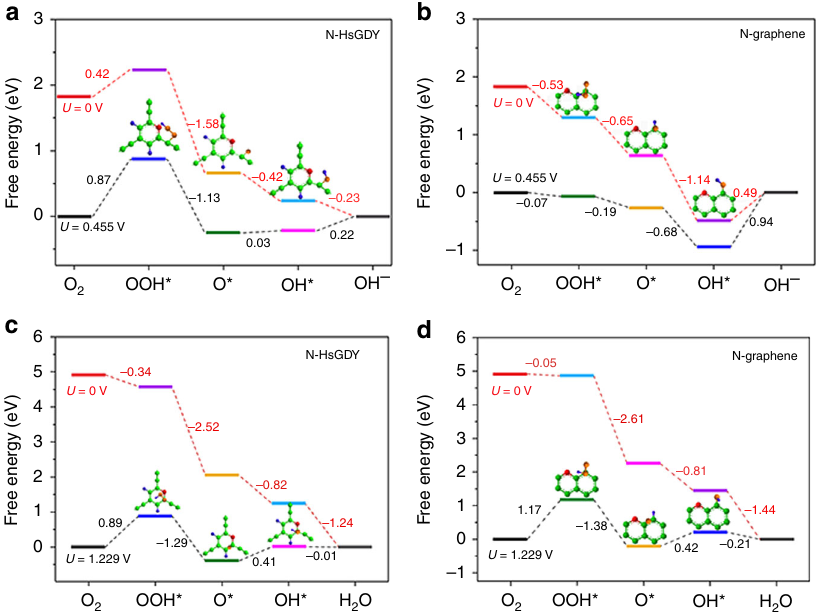
Fig. 7 Mechanistic study for the oxygen reduction reaction. a , b Free energy diagrams of the oxygen reduction reaction (ORR) on pyridinic nitrogen-doped hydrogen-substituted graphdiyne (N-HsGDY) ( a ) and pyridinic N-doped graphene edge (N-graphene) ( b ) at 0.455 and 0 V (vs. normal hydrogen electrode, NHE) in alkaline media. c , d Free energy diagrams of ORR on pyridinic N-doped HsGDY ( c ) and pyridinic N-doped graphene edge ( d ) at 1.229 and 0 V (vs. NHE) in acidic